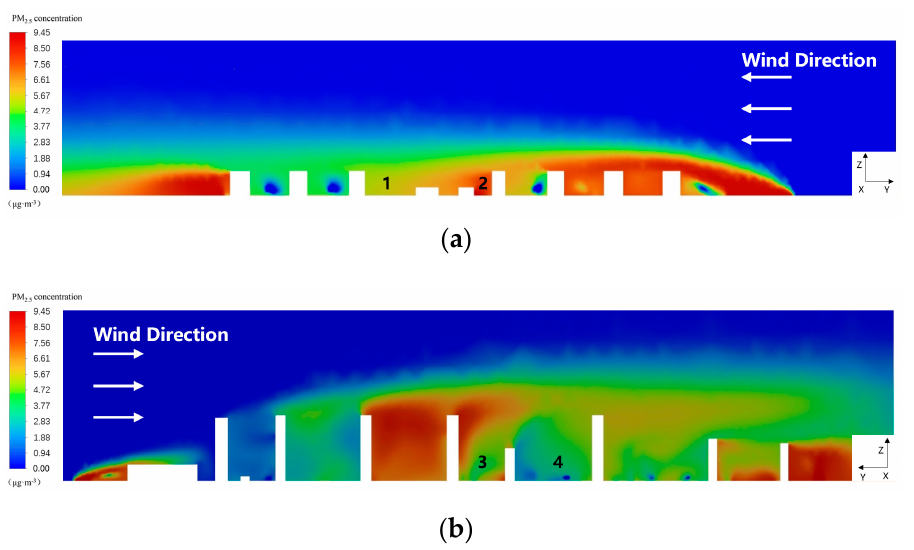
Figure 11. PM 2.5 diffusion distribution of typical Y-Z section in: ( a ) Neighborhood A; ( b ) Neighbor- hood B.